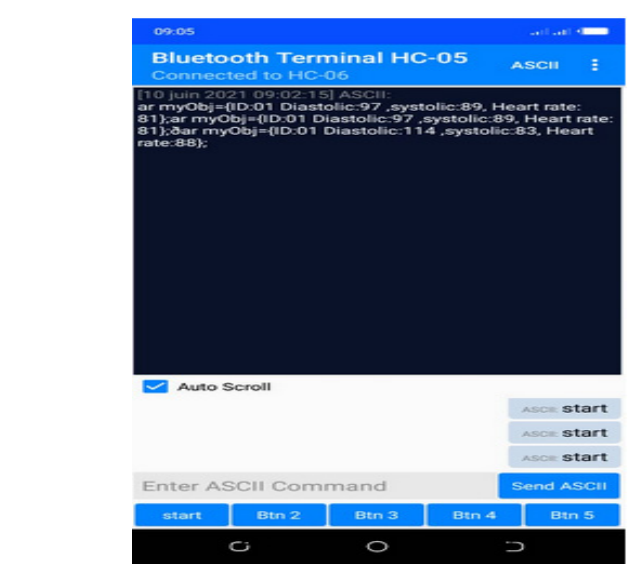
Figure 4. ( A – D ) shows respectively the prototype system flowchart, the screen for collecting the patient data and notifications, the logging page of our application, and collecting the patient data through Bluetooth interface.